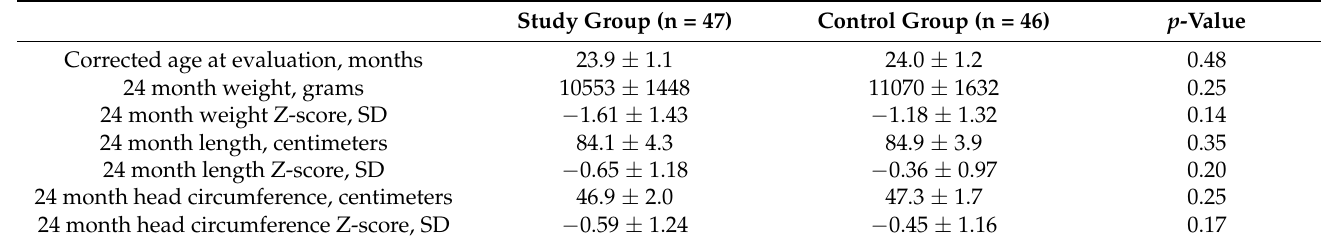
Table 3. Anthropometric evaluation in the two groups at 24 months CA.